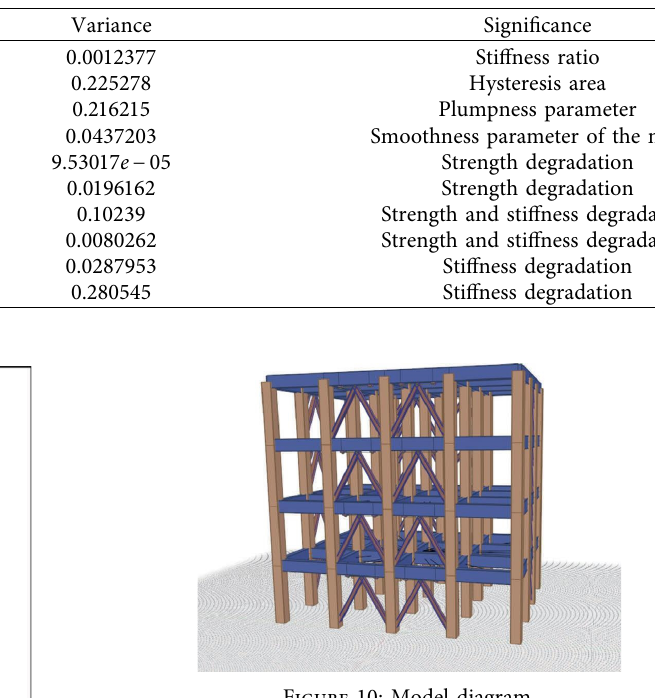
Table 2: Parameter estimation and variance.